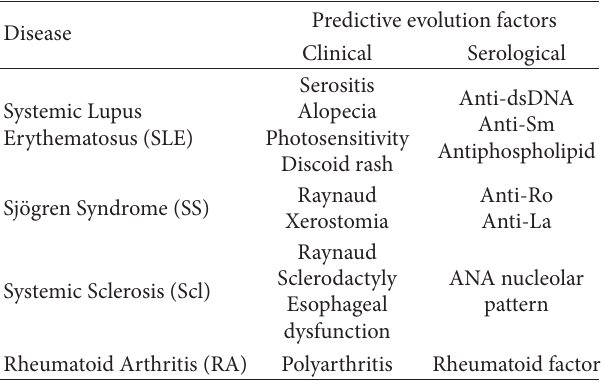
Table 1: Clinical and serological markers that predict the evolution to each definite connective tissue disease (CTD).